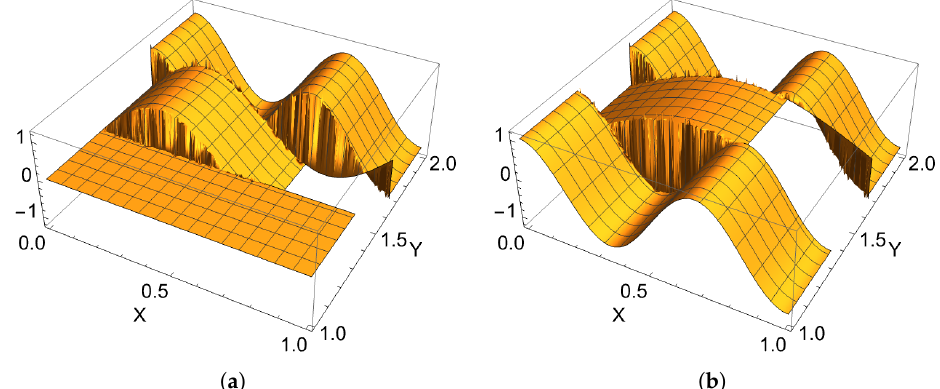
Figure 5. Three regions. Realizations of the Young’s modulus in different configurations. The region with index 1 is set to zero for visualization purposes only. ( a ) Dimension index i = { 1,3,4 } , ( b ) Dimension index i = { 4,2,3 } .